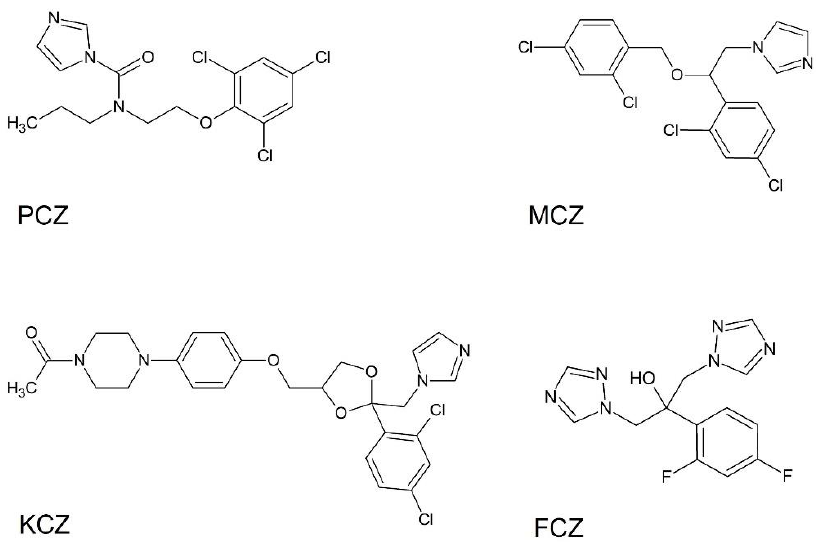
Figure 1. Chemical structures of the investigated antifungal azoles: prochloraz (PCZ), miconazole (MCZ), ketoconazole (KCZ), and fluconazole (FCZ).